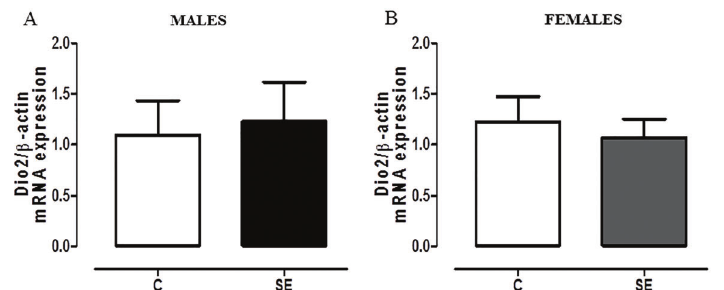
Figure 5. Long-term effects of neonatal cigarette smoke exposure on brown adipose tissue (BAT) Dio2 mRNA expression at 180 postnatal days in males ( A ) and females ( B ). C: control group; SE: smoke-exposed group. Data are reported as means ± SE for n=6 – 8 ( t